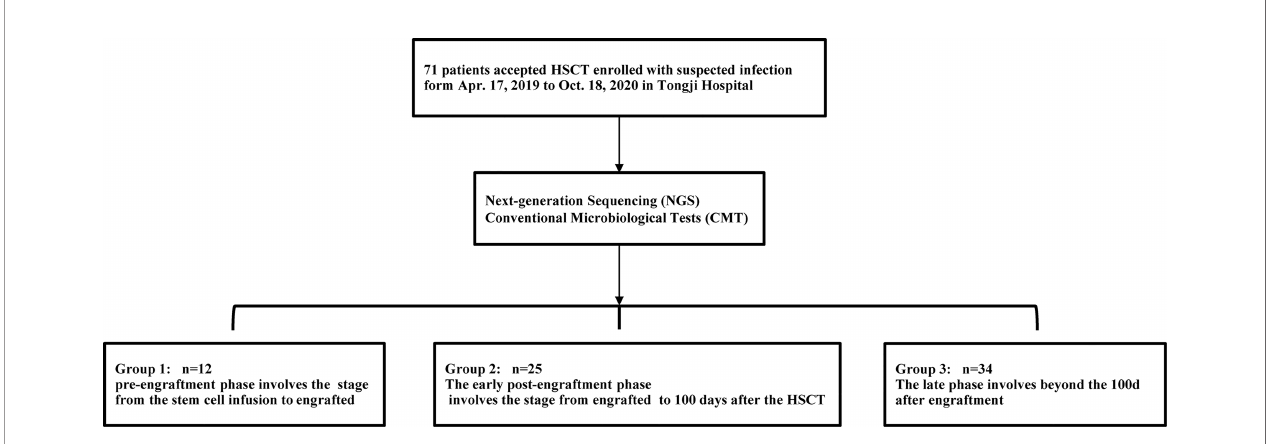
FIGURE 2 | Trial process. Between Apr.17, 2019 to Oct.18, 2020, 71 patients who developed fever with/without other symptoms after the transfusion and underwent CMT and NGS tests were screened for eligibility in this study. In terms of the time of clinical symptoms appeared, the patients were divided into